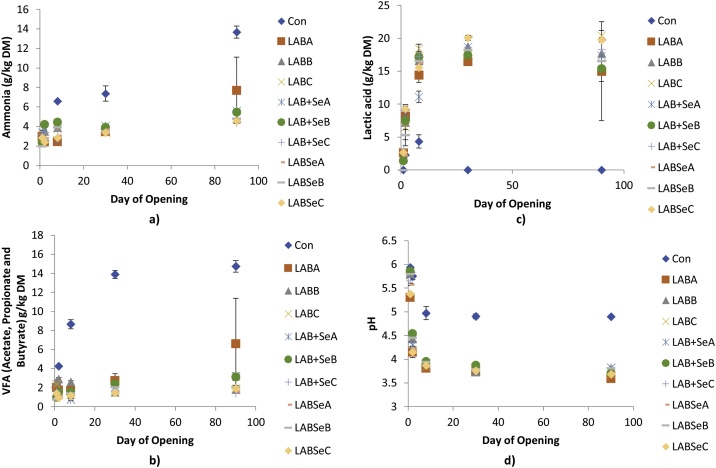
Mini silo silage quality parameters at opening. a) Ammonia-N; b) VFA, Volatile Fatty Acids’ c) Lactic Acid; d) pH. Con, Control with no inoculant; LAB A, Inoculant A ensiled; LAB B, Inoculant B ensiled; LAB C, Inoculant C ensiled; LAB + Se A, Se added to inoculant A at ensiling; LAB + Se B, Se added to inoculant B at ensiling; LAB + Se C, Se added to inoculant C at ensiling; LABSe A, Se cultured with inoculant A pre-ensiling; LABSe B, Se cultured with inoculant B pre-ensiling; LABSe C, Se cultured with inoculant C pre-ensiling. Means presented with standard error of the mean. Significance between treatments at P < 0.05 represented here by lack of overlapping error bars.